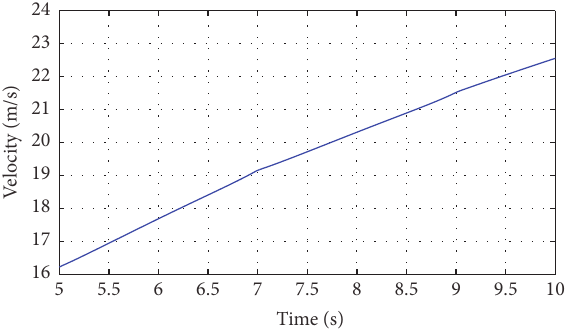
Figure 13: Vehicle velocity during the sinusoidal